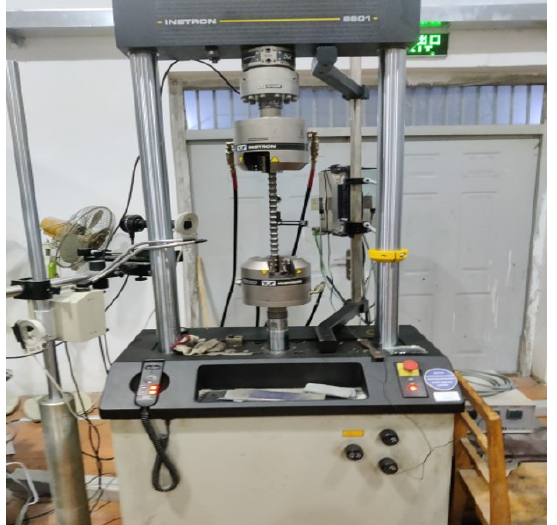
Figure 2. Experimental set-up.